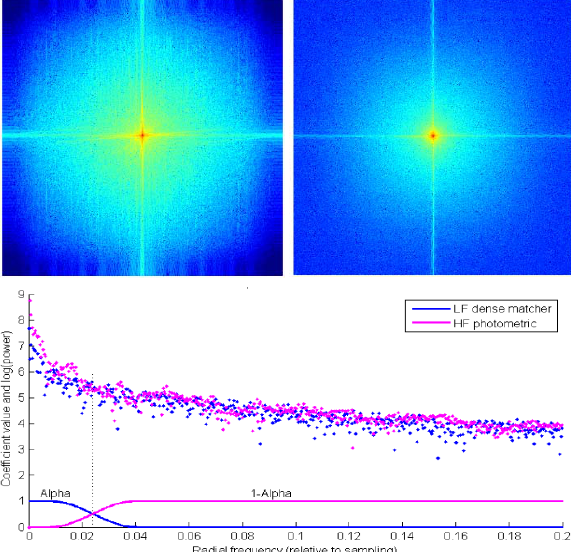
Figure 15. Stages in generating an outline: (top left) mean image with cross-section; (top right) elevation of intensity; (bottom left) binary mask; (bottom right) outline point set.